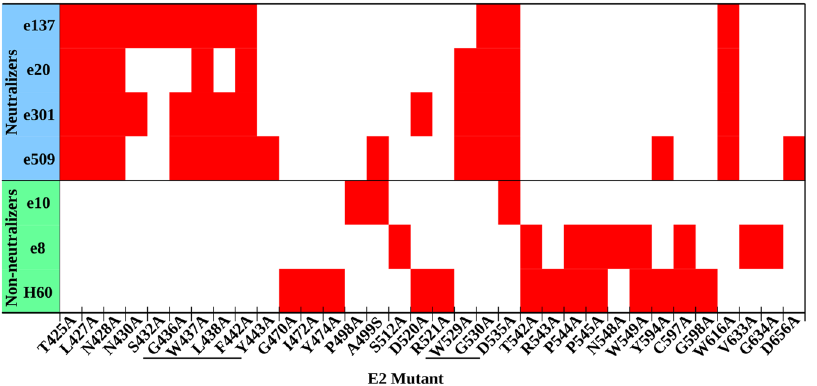
Figure 2. Critical residues abrogating mAb binding. Antibodies are divided into neutralizers and non- neutralizers. Epitope residues are marked in red, while residues that are part of the CD81bs are underlined. The threshold below which a decrease in reactivity defines a residue as part of an epitope was determined for each antibody (e137 < 15%, e20 < 20%, e301 < 20%, e509 < 15%, e10 < 30%, e8 < 20%, H60 <